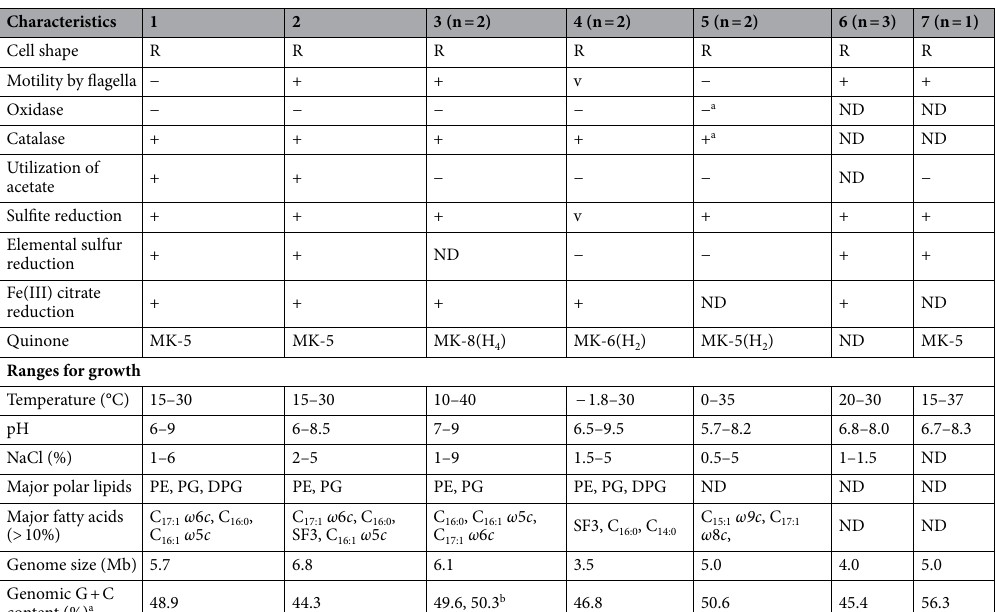
Table 1. Characteristics that differentiate strains IMCC35004 T and IMCC35005 T from all the genera of the family Desulfocapsaceae. Strains: 1, IMCC35004 T ; 2, IMCC35005 T ; 3, Desulfopila 16,29; this study ; 4, Desulfotalea 15; this study ; 5, Desulforhopalus 14,30 ; 6, Desulfocapsa 13,31 ; 7, Desulfofustis 12 . n, number of species; + , positive; –, negative; v, variable; R, rod; ND, no data; PE, phosphatidylethanolamine; PG, phosphatidylglycerol; DPG, diphosphatidylglycerol; and SF3, summed feature 3 (C 16:1 ω 7 c and/or C 16:1 ω 6 c ). a Values calculated from the genomic data unless otherwise indicated. b Value calculated using high-performance liquid